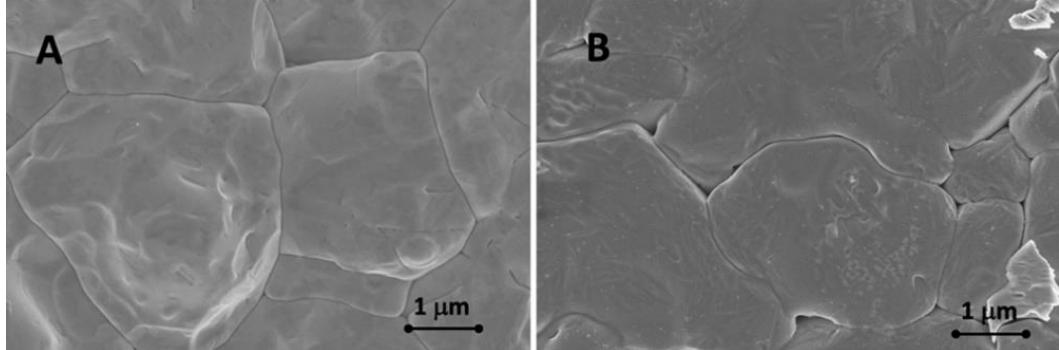
Figure 11. CdCl 2 treated CdTe deposited by CSS ( A ) and by vacuum evaporation ( B ).